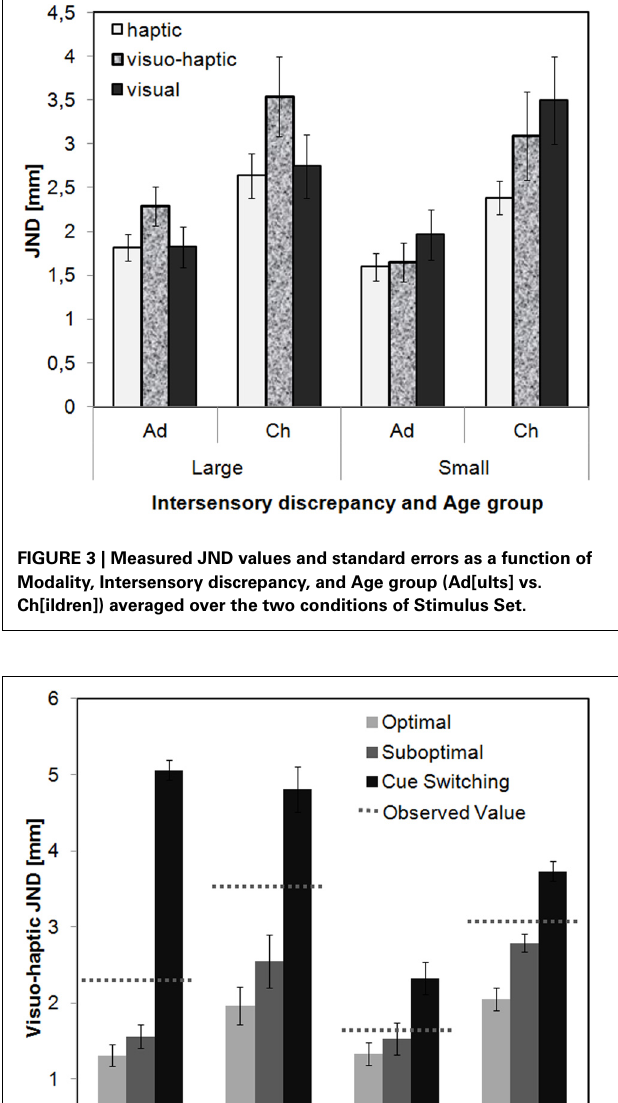
Optimal integration Using the model of optimal integration, we predicted optimal visual weights and optimal JNDs in bisensory conditions based on the corresponding unisensory